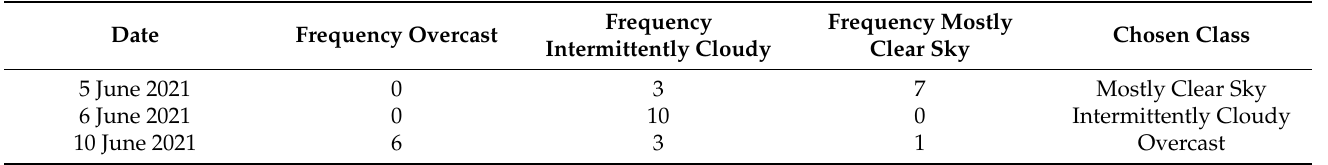
Table 6. Class Frequency for 3 specific days (See Figure 7c,d).